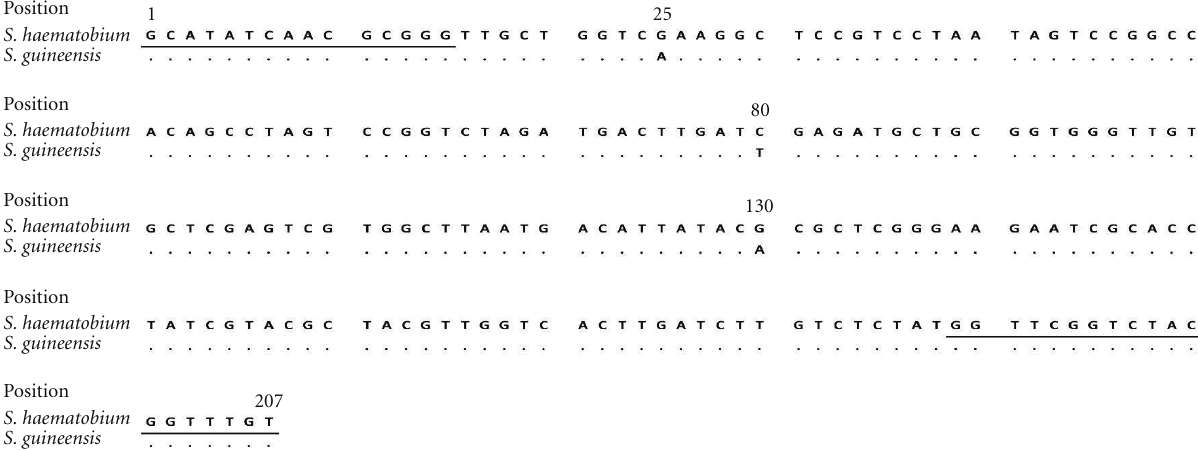
Figure 4: ITS2 fragment sequences showing the three single-nucleotide polymorphisms between S. haematobium and S. guineensis . The priming sites are